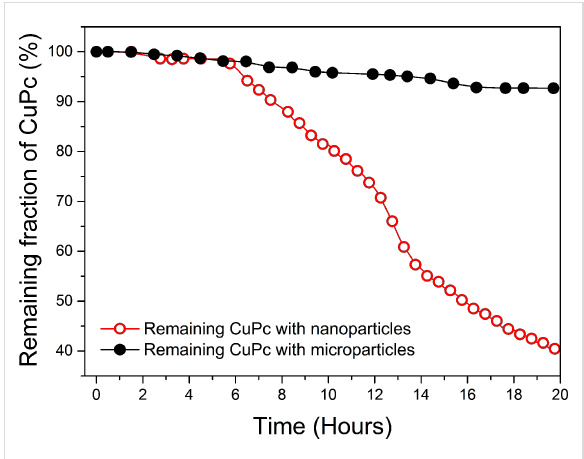
Figure 4: Rate of CuPc decoloration (initial concentration: 0.1 mg/L) in suspensions of pyrite nanoparticles (average size: 20 nm; red circles) or microparticles (average size: 1.4 μ m; black circles), at loadings of 0.08 g/L.